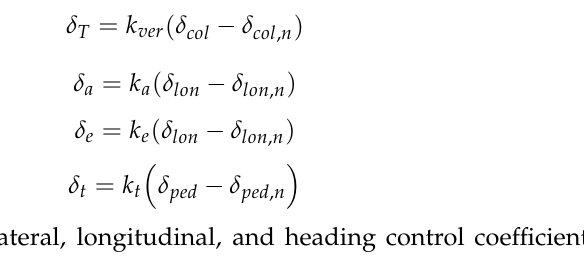
Combined with Equation (29), the Newton–Raphson algorithm is used to solve the equilibrium equations. The trim characteristics can be calculated with and without interfer- ence according to the procedure diagram shown in Figure